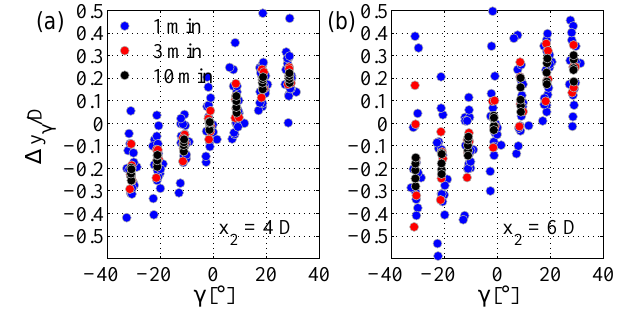
Table 2. Standard deviation of the wake deflection at x 2 = 6D